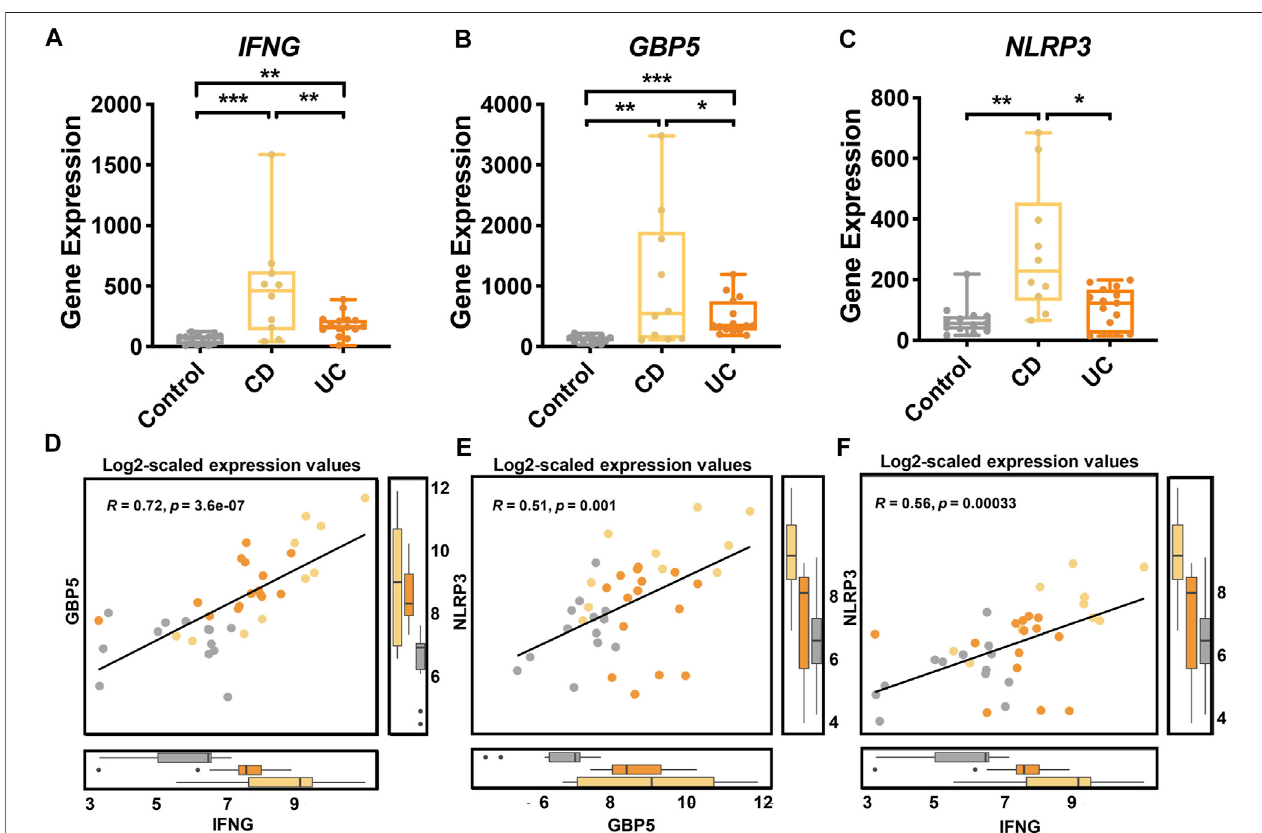
FIGURE 6 | Gene expression of IFNG , GBP5 , and NLRP3 in healthy controls, CD, and UC patients according to transcriptome analysis. The expression of (A) IFNG , (B) GBP5 ,and (C) NLRP3 genesinthecontrol,CD,andUCgroups.Yellow,CD;orange,UC;gray,control.Alldataarepresented asmean±standarderror.*: p < 0.05; **: p < 0.01; ***: p < 0.001. N = 10, 15, and 13 for the CD, the UC, and the control groups, respectively. (D) Linear regression between IFNG and GBP5 based on log2-scaled expression values (Spearman; R = 0.72, p = 3.6e-07). (E) Linear regression between GBP5 and NLRP3 based on log2-scaled expression values (Spearman; R = 0.51, p = 0.001). (F) Linear regression between IFNG and NLRP3 based on log2-scaled expression values (Spearman; R = 0.56, p =